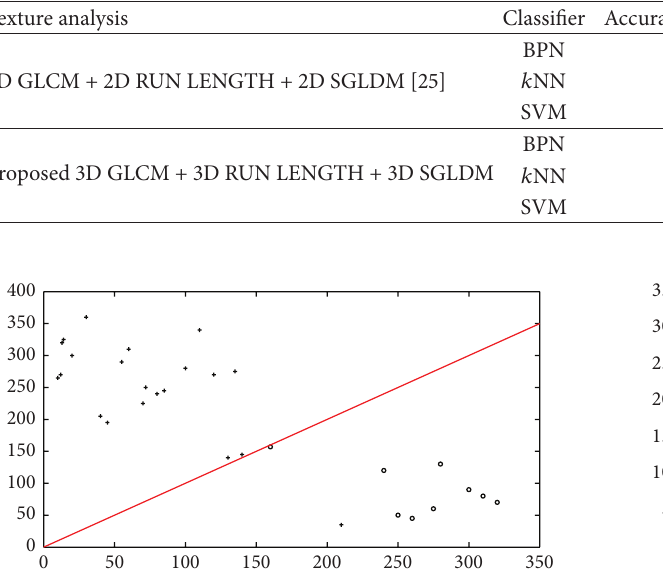
Figure 12: Scatter plot of real-time sample set (30) on 𝑘 NN classifier for benign and malignant tumor in real-time image dataset. Here “ ∘ ” denotes tumor malignant prognosis and “+” denotes patients with benign tumor prognosis.